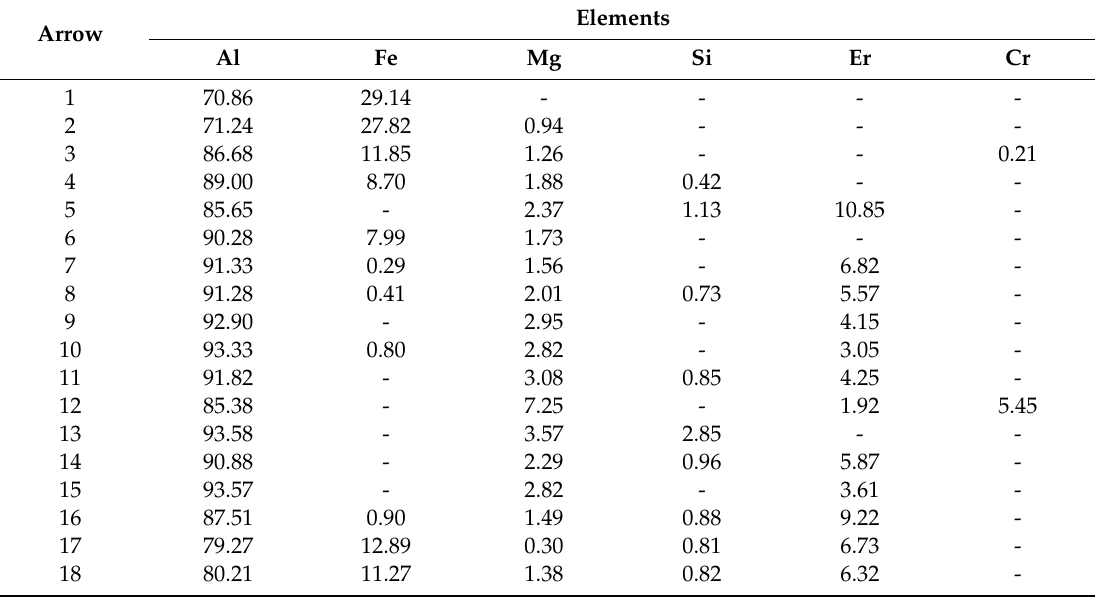
Table 2. EDS results of the second phase of as-cast and homogenized 5052 aluminum alloys (at. %). Arrow